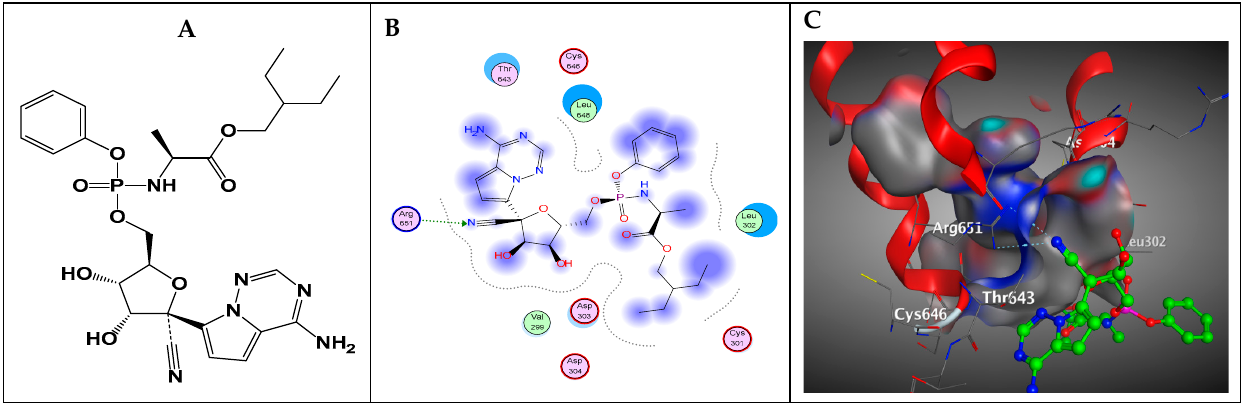
Figure 1. ( A ) Structure of the standard inhibitor Remedesivir, ( B ) 2D pose and ( C ) surface map of the interaction of Remedisvir into the active site of SARS-Cov-2 RdRp (PDB: 7bv2).